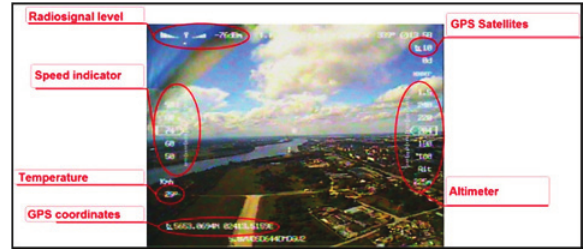
Fig. 3. View from UAV navigation camera while in